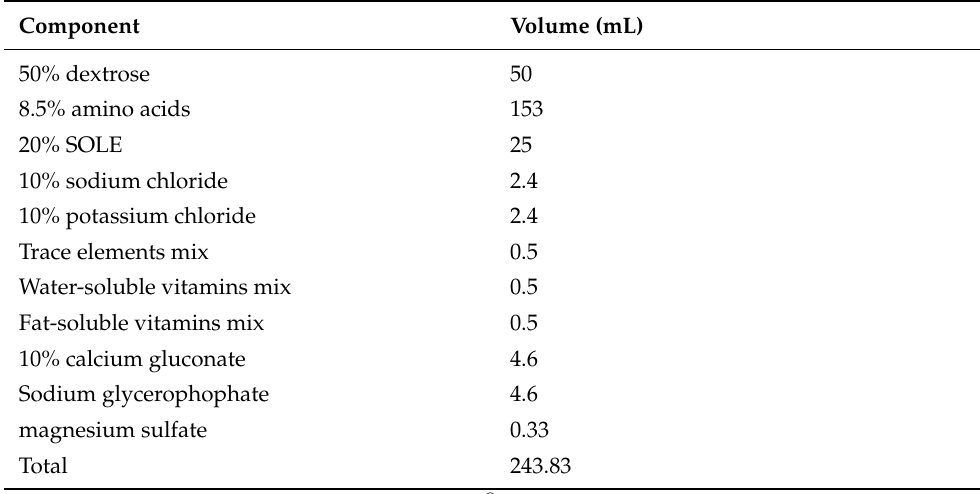
Table 1. Components of TPN